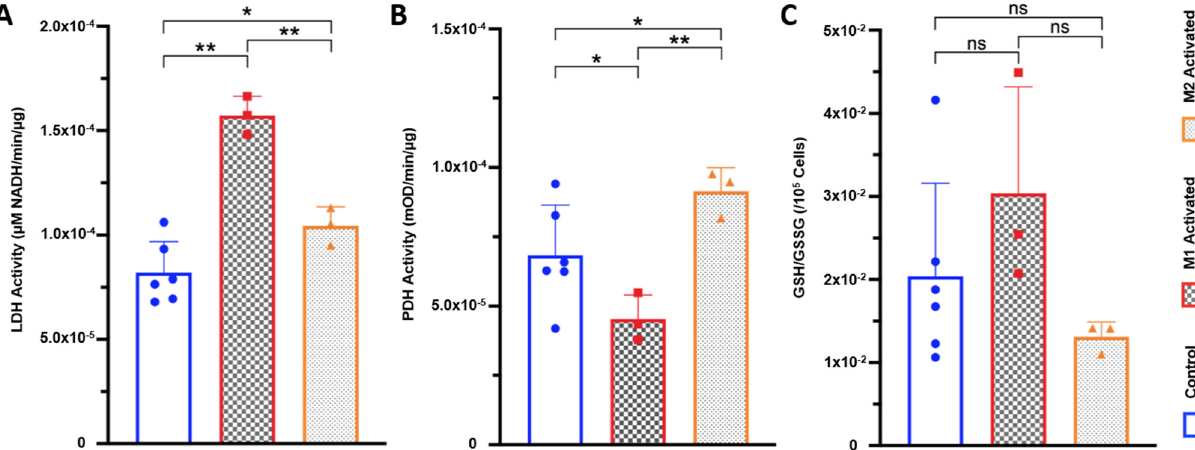
Figure 4. LDH and PDH activities are differentially modulated with M1/M2 activation ( A ) Lactate dehydrogenase (LDH) enzyme activity for control (blue), M1-activated (red), and M2-activated (orange) macrophages (* p < 0.05, ** p < 0.01, normalized to protein concentration). ( B ) Pyruvate dehydrogenase (PDH) enzyme activity measured by spectrophotometry for control (blue), M1-activated (red), and M2-activated (orange) macrophages (* p < 0.05, ** p < 0.01, normalized to protein concentration). ( C ) Reduced glutathione (GSH) over oxidized glutathione (glutathione disulfide, GSSH) GSH/GSSG ratio per 105 cells for control (blue), M1-activated (red), and M2-activated (orange) macrophages ( NS control vs. M1: p = 0.1265; NS control vs. M2: p = 0.8326; NS M1 vs. M2: p = 0.1083).